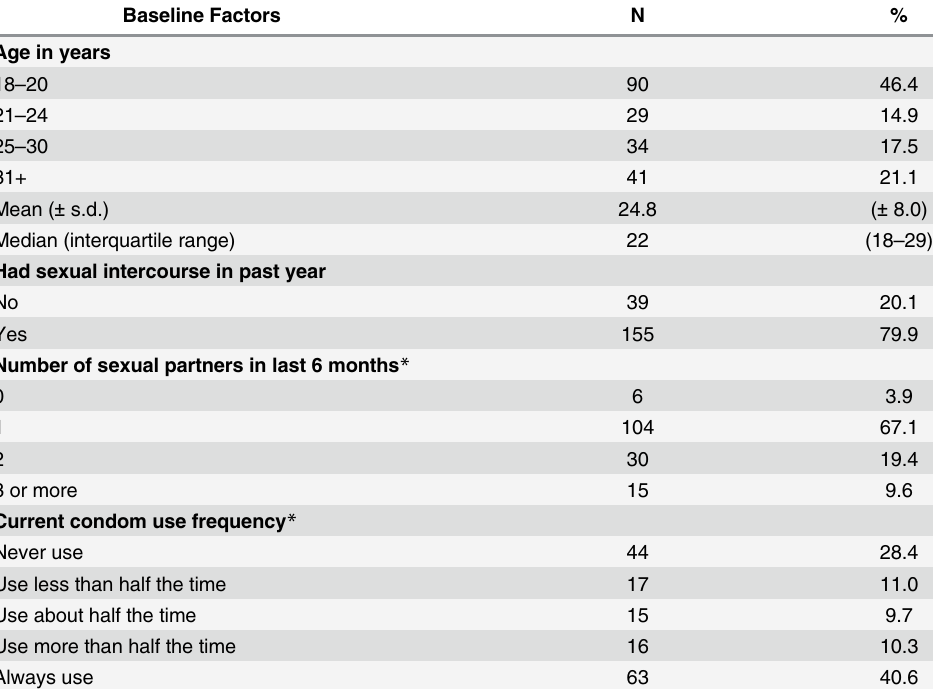
Table 1. Selected Baseline Features of Men at ShangRing Circumcision Visit who were Interviewed 2 + Years Later (N =